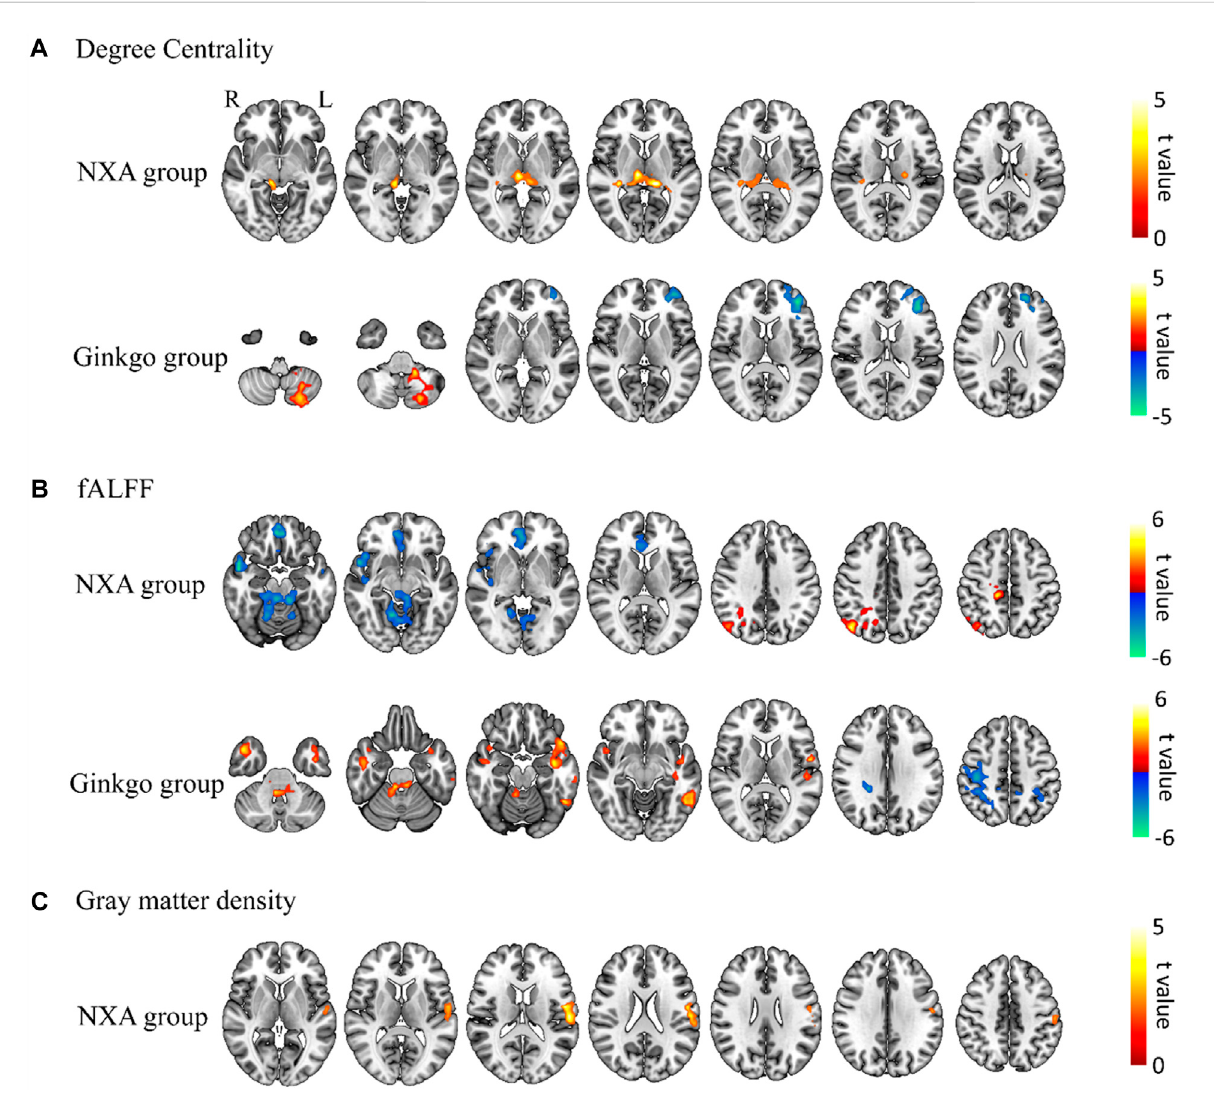
FIGURE 4 Pairedt-testresults for brainfunctionand structurefor pre-and post-treatment.Changesindegree centrality (A) ,fALFF (B) ,and graymatterdensity (C) post-treatment compared with pre-treatment. The signi fi cance level was set at a voxel-level inference of p < 0.001 combined with a cluster-level inference of p < 0.05